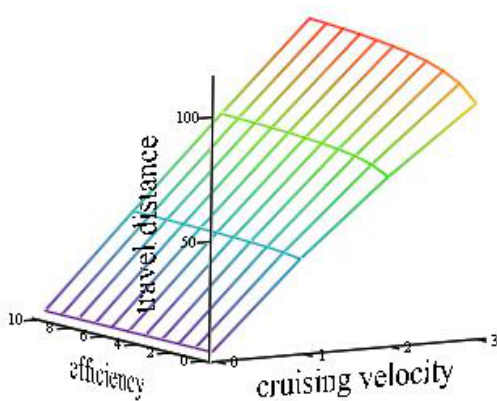
Figure 5. Travel distance vs. payload.